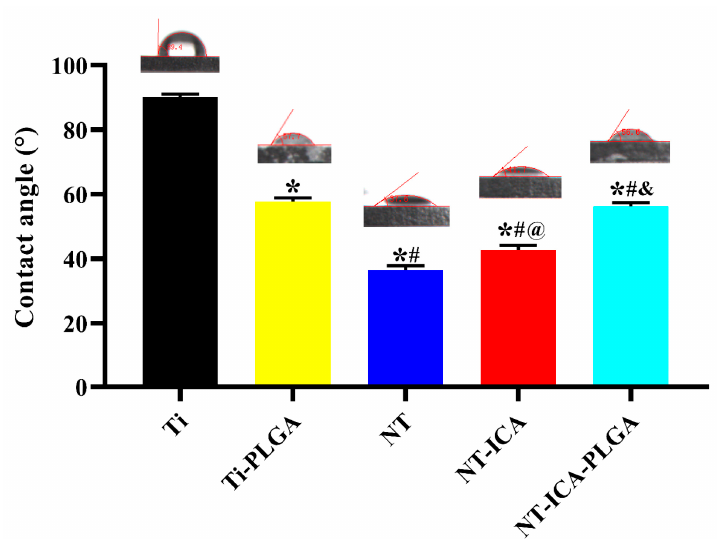
Figure 3. Contact angle of different samples. * indicate statistical significance compared to Ti, # indicate statistical significance compared to Ti-PLGA, @ indicate statistical significance compared to NT and & indicate statistical significance compared to NT-ICA group ( p < 0.05). The values were calculated as mean ± standard deviation, n = 3. The experiments were repeated three times.